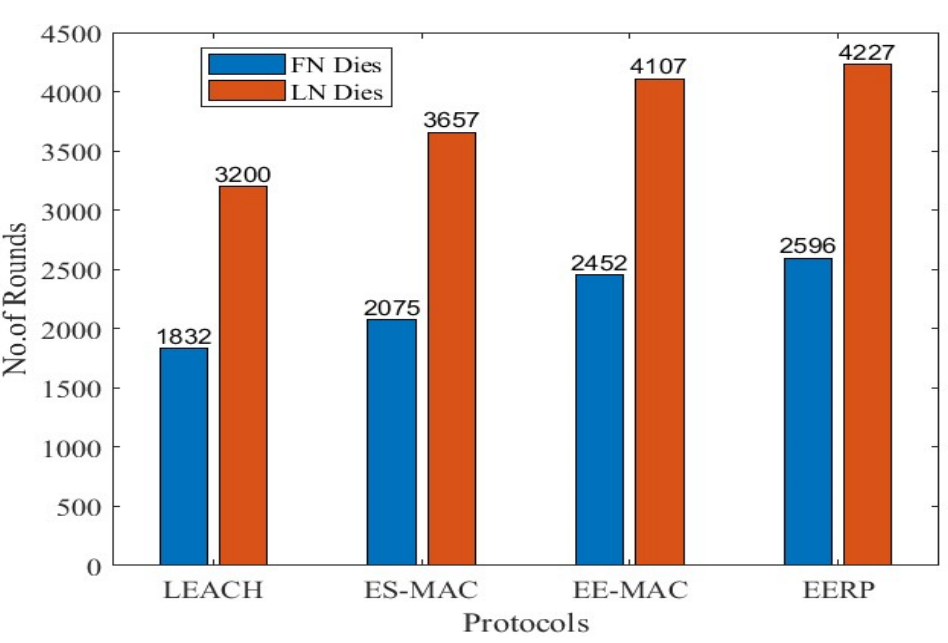
Figure 13. FN and LN deaths in Scenario 3.